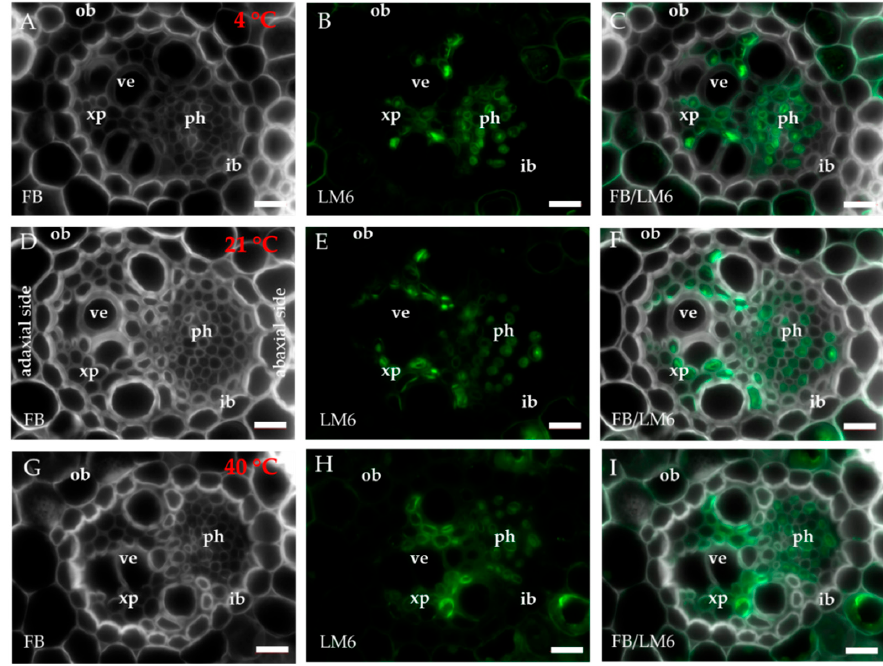
Figure 6. Immunolocalisation of the LM6 epitope ( A – I ) in cross ‐ sections of the B. distachyon leaves, ( A – I ): through the major vascular bundle. ( A – C ): 4 °C; ( D – F ): 21 °C; ( G – I ): 40 °C. Abbreviations: FB—fluorescent brightener, ib—inner bundle sheath, ob—outer bundle sheath, ph—phloem, ve—vessels, xp—xylem parenchyma. The green colour shows epitope occurrence. Scale bars: 10 μ m.